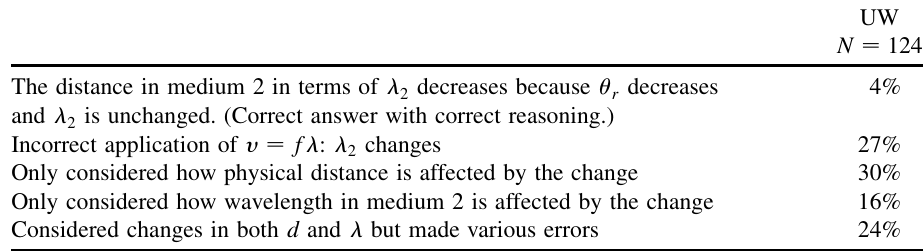
TABLE III. Summary of results from the thin-film interference problem after all instruction at UW.